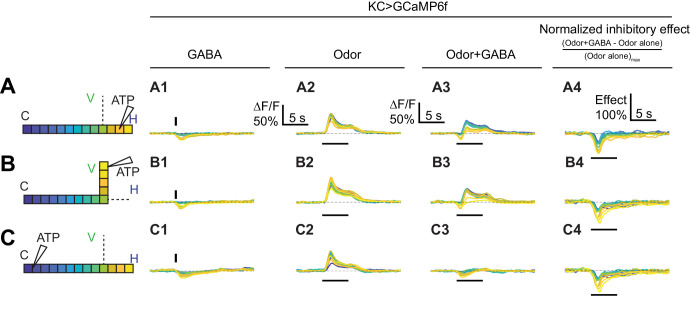
Time courses of GABA’s effect on KC activity.Rows: Local application of GABA (7.5 mM) in the horizontal lobe (A1–A2), vertical lobe (B1–B2) or calyx (C1–C2). Columns: Responses of KCs to GABA application (A1–C1), the odor isoamyl acetate (A2–C2), or both (A3–C3). (A4–C4) Normalized inhibitory effect of GABA application on KC responses to isoamyl acetate. Traces show the time course of the response in each segment of KCs, averaged across flies. Color-coded backbone indicates which segments have traces shown (dotted lines mean the data is omitted for clarity; the omitted data appear Figure 7). Vertical and horizontal bars indicate the timing of GABA and odor stimulation, respectively.